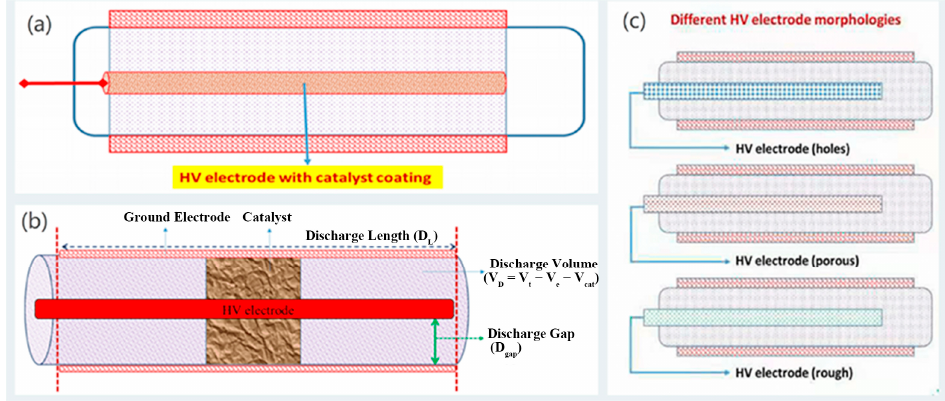
Figure 6. ( a ) The typical geometry of a DBD plasma reactor system; ( b ) the morphology of three different high-voltage electrode materials; ( c ) three morphologies of high-voltage electrode materials. Reproduced with permission from [8], Copyright 2019, Elsevier.